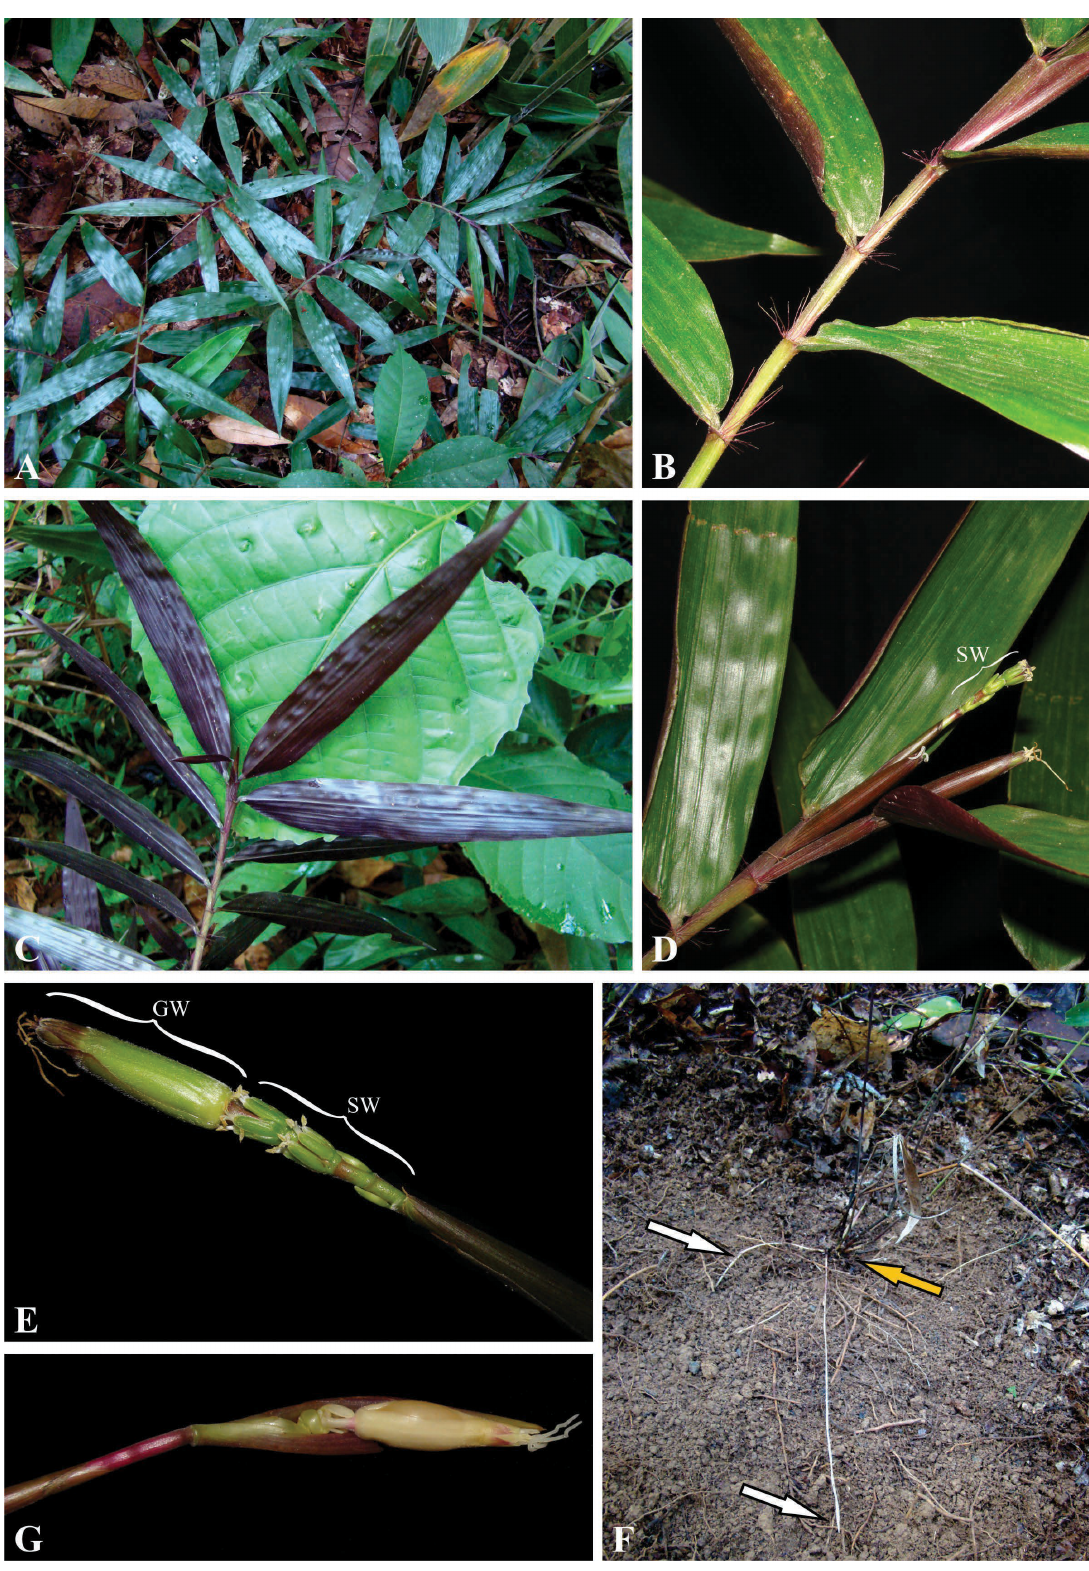
Figure 5 – Eremitis vinacea (photographs by Fabrício M. Ferreira). A . Habit. B . Detail of the leafy culm showing the fimbriae at the apex of the leaf sheaths. C . Leaf blades, abaxial view. D . Leafy culm inflorescences enclosed by spathaceous bracts. E . Decumbent culm inflorescence with spathaceous bracts removed, showing a gynecandrous whorl (GW) above and three staminate whorls (SW) below. F . Subterranean culms (white arrows). Yellow arrow indicates the base of the clump. G . Subterranean culm inflorescence enclosed by spathaceous